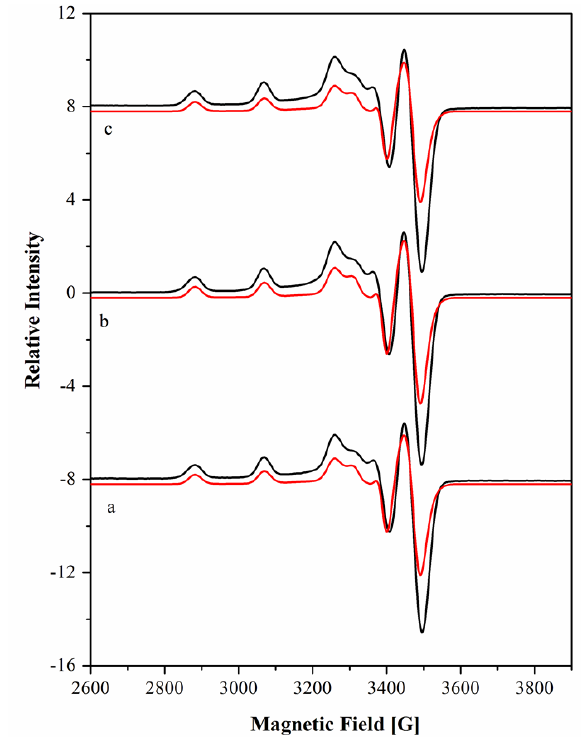
Figure 4. EPR X-band spectra of Cu(II) complex of [15]aneN S in 1:1 ratio at pH 4.10 ( a ), 4 7.40 ( b ) and 9.00 ( c ) in 1.0 M of NaClO . The spectra were recorded at 104 K, microwave 4 power of 2.0 mW and modulation amplitude of 1.0 mT. The frequency ( ν ) was of 9.67 GHz. The simulated spectra (red lines) are below of the experimental ones (black lines).